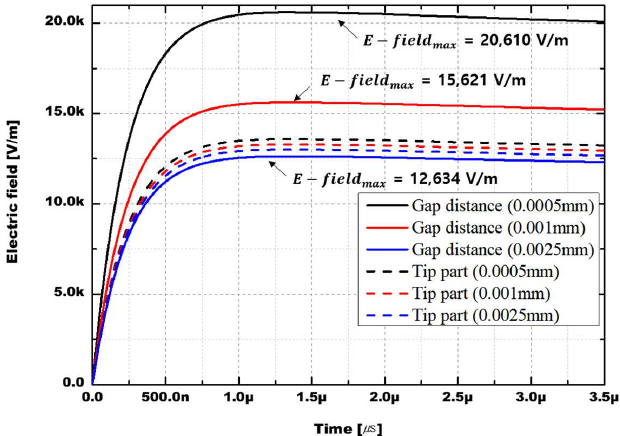
Figure 2. Electric field as a function of time at 0.5 kV (solid line: air space between ionizer conductor and current collector, dash line: tip part of SK-AOR380 lightning rod).